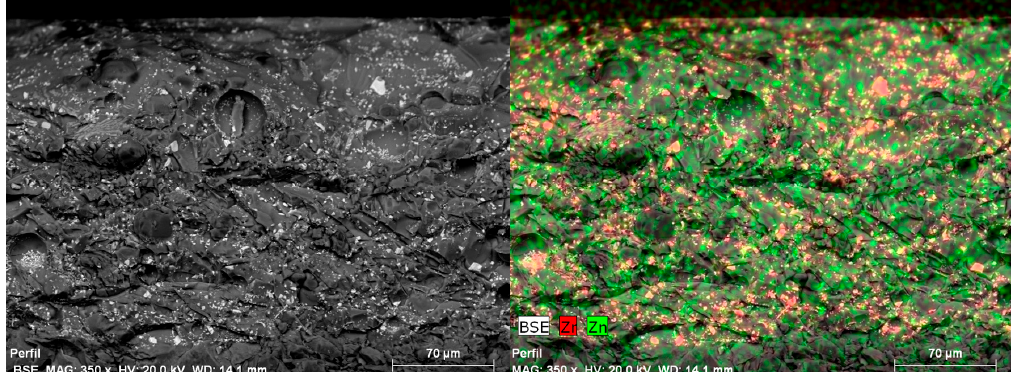
Figure 9. SEM applying 350 magnifications of the ZrO 2 glaze. Homogeneous distribution of Zr and Zn.